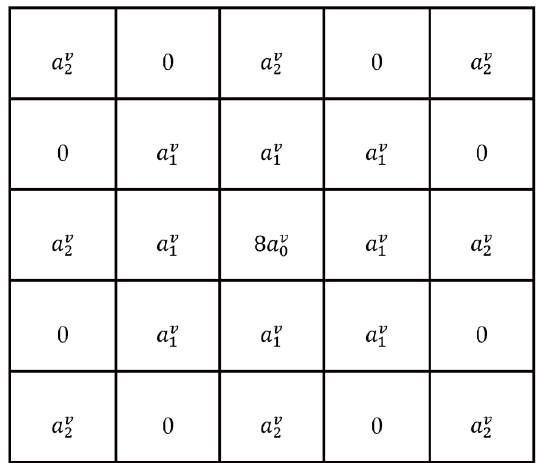
Figure 8. Fractional−order differential mask.